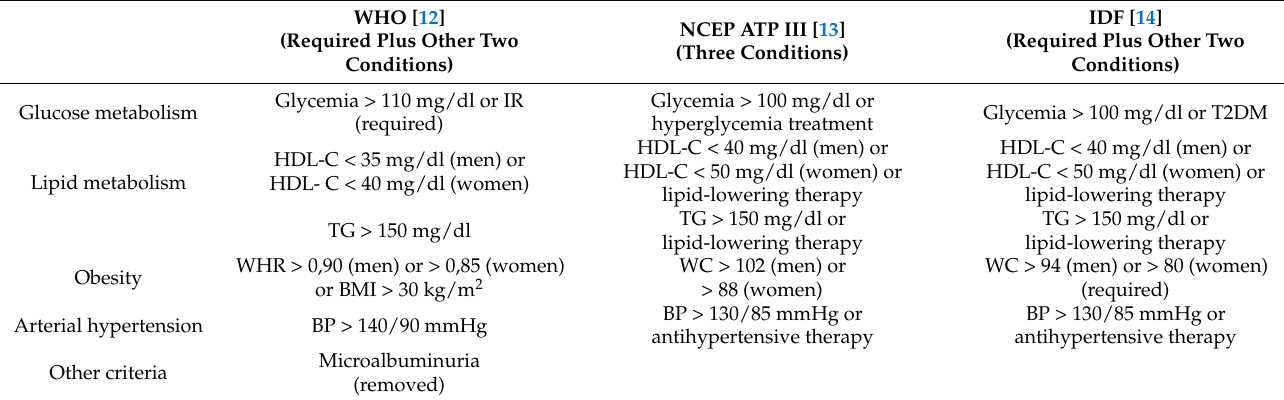
Table 1. Principal definitions of MetS.